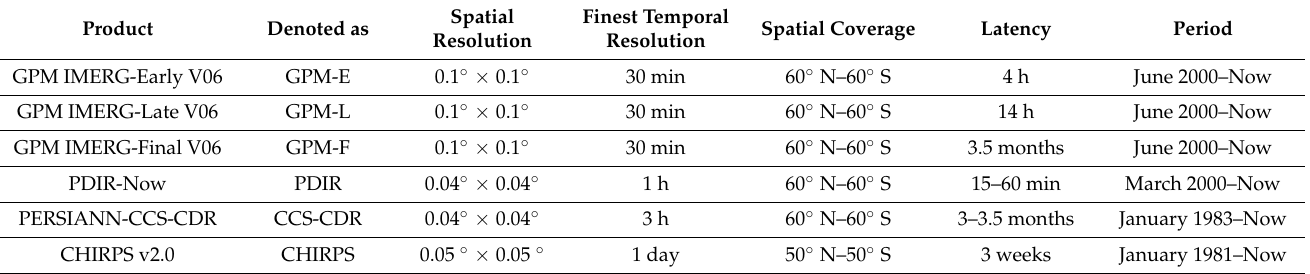
Table 2. Summary of satellite precipitation products used in this